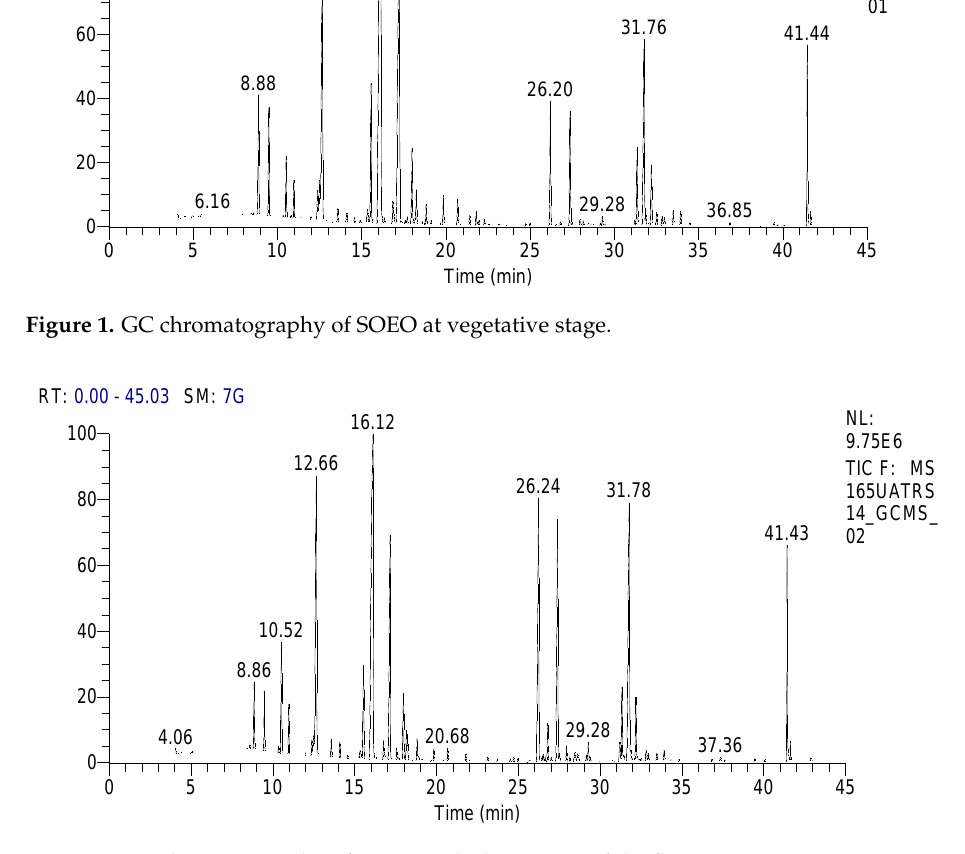
Figure 3. GC chromatography of SOEO at full flowering stage. Regarding oxygenated monoterpenes, naphthalenone was the major compound with percentages of 22.9, 22.39, and 20.81% for the vegetative stage (VS), beginning of flowering stage (BFS), and full flowering stage (FFS), respectively. The second main compound was camphor, which showed the highest percentage during the vegetative stage (16.29%), followed by 1.8-cineole (12.51%), and α-thujone (4.46%). However, for sesquiterpene hydrocarbons, the full flowering stage showed the highest concentrations of major compounds; trans-caryophyllene (9.61%), eremophilene (8.37%), and α-humulene (8.34%) (Table 1). Table 1. Chemical composition of S. officinalis at three phenological stages . Peak Area% RT